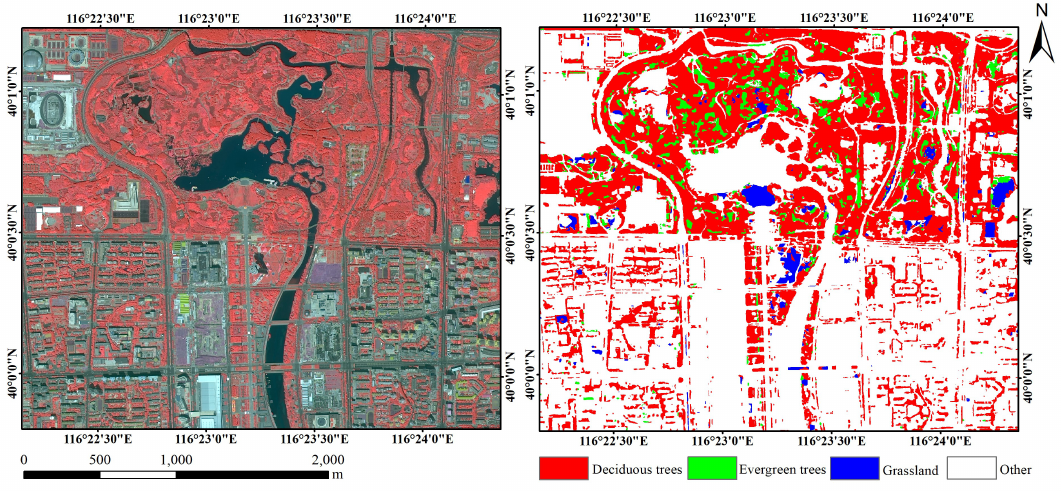
Figure 2. Test area and Ground